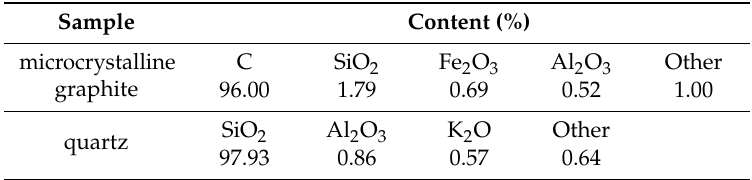
Table 3. Chemical analysis of microcrystalline graphite and quartz